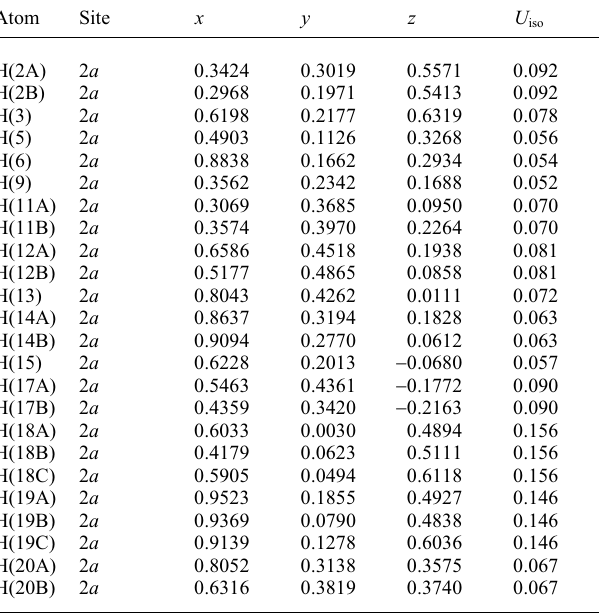
Table 2. Atomic coordinates and displacement parameters (in Å 2 )